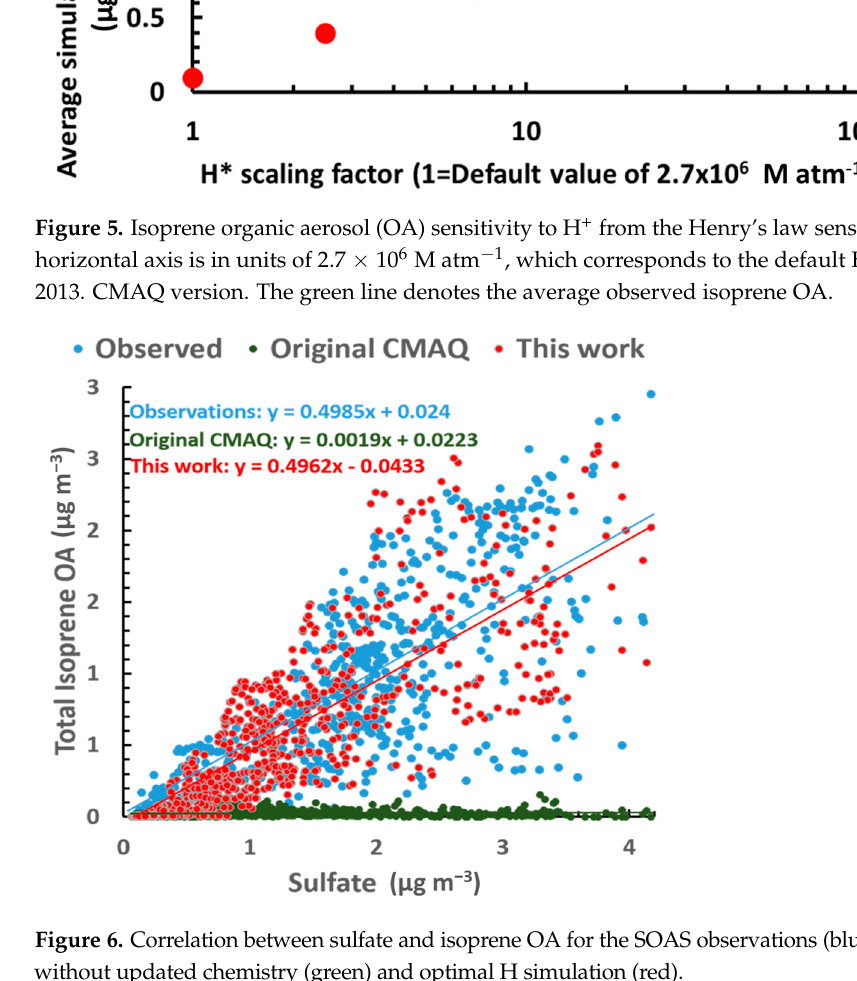
Figure 6. Correlation between sulfate and isoprene OA for the SOAS observations (blue), base scenario without updated chemistry (green) and optimal H simulation (red).